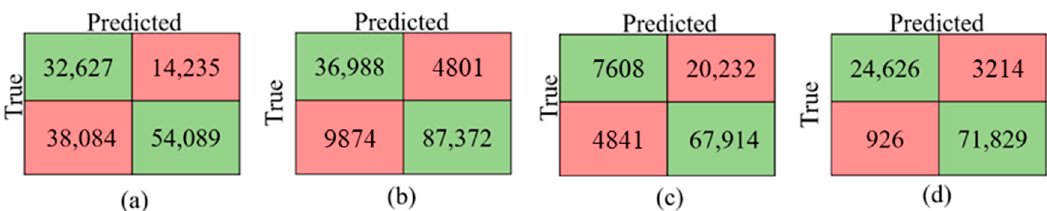
Figure 7. The result of the damage detection in both datasets. ( a ) The ND-Based method, ( b ) Proposed method in Sarpol-Zahab, ( c ) The ND-Based method, and ( d ) Proposed method in Qasr-Shirin.